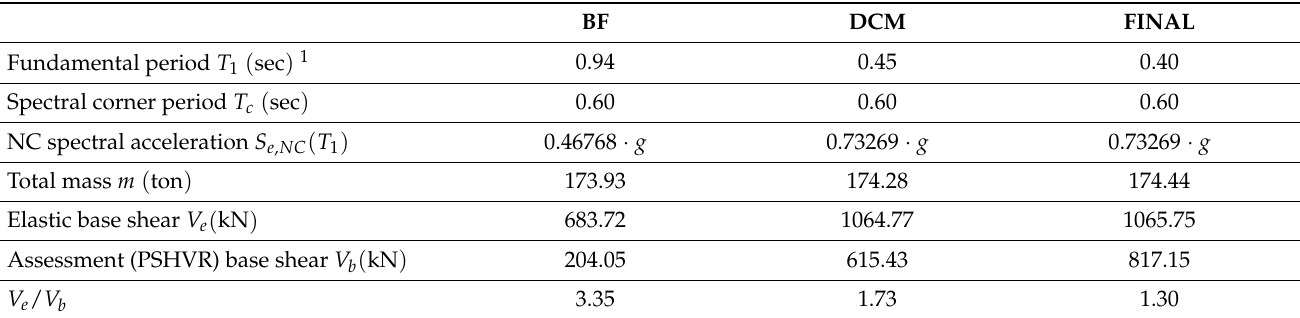
Table 7. Bare (BF) and retrofitted (DCM; FINAL) frames: key global parameters comparison. BF